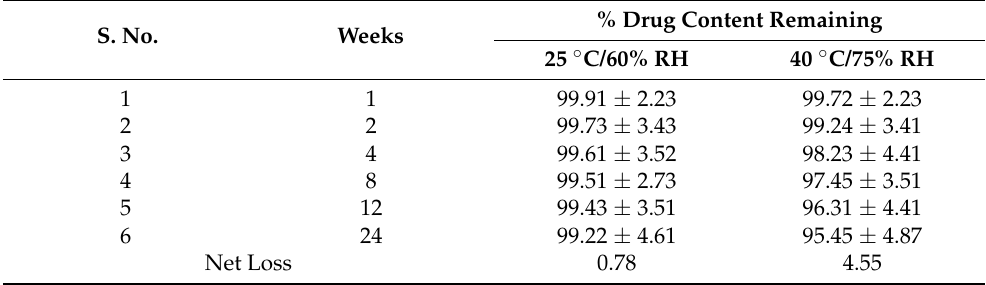
Table 2. Measurement of drug content of baicalin-loaded LPHNPs at different temperatures (n = 6). S.